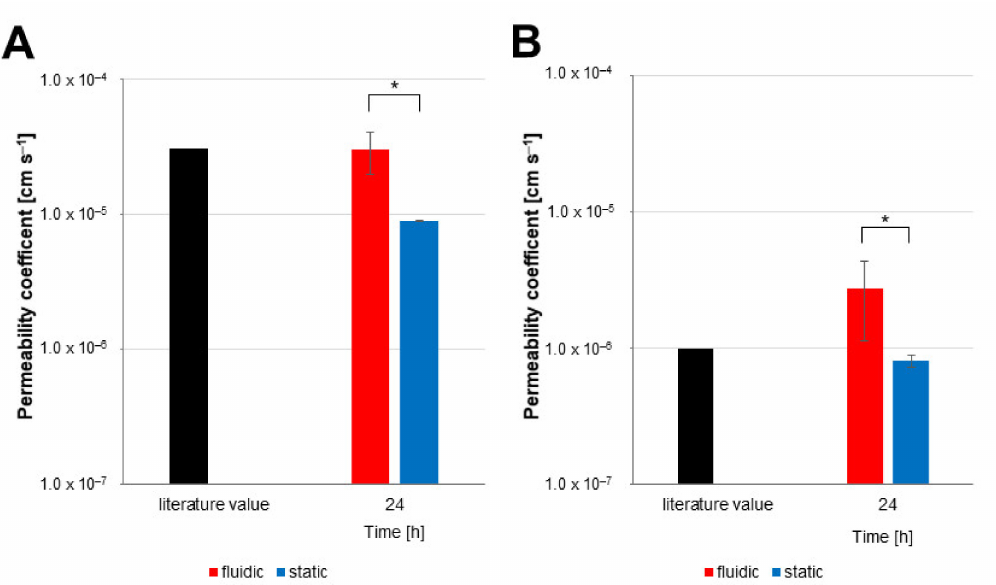
Figure 7. Permeability coefficients of caffeine and sodium fluorescein in the presence or absence of fluidic flow. Determination of permeability coefficients was performed for ( A ) caffeine and ( B ) sodium fluorescein. To the apical compartment of the models, 100 µ M caffeine and 1 µ M sodium fluorescein was applied at day 10 of development (fluidic—red; static—blue) and samples of both circuits were taken for measurement at the indicated time point. Mean ± S.D. was calculated for three biological replicates, * p < 0.05.